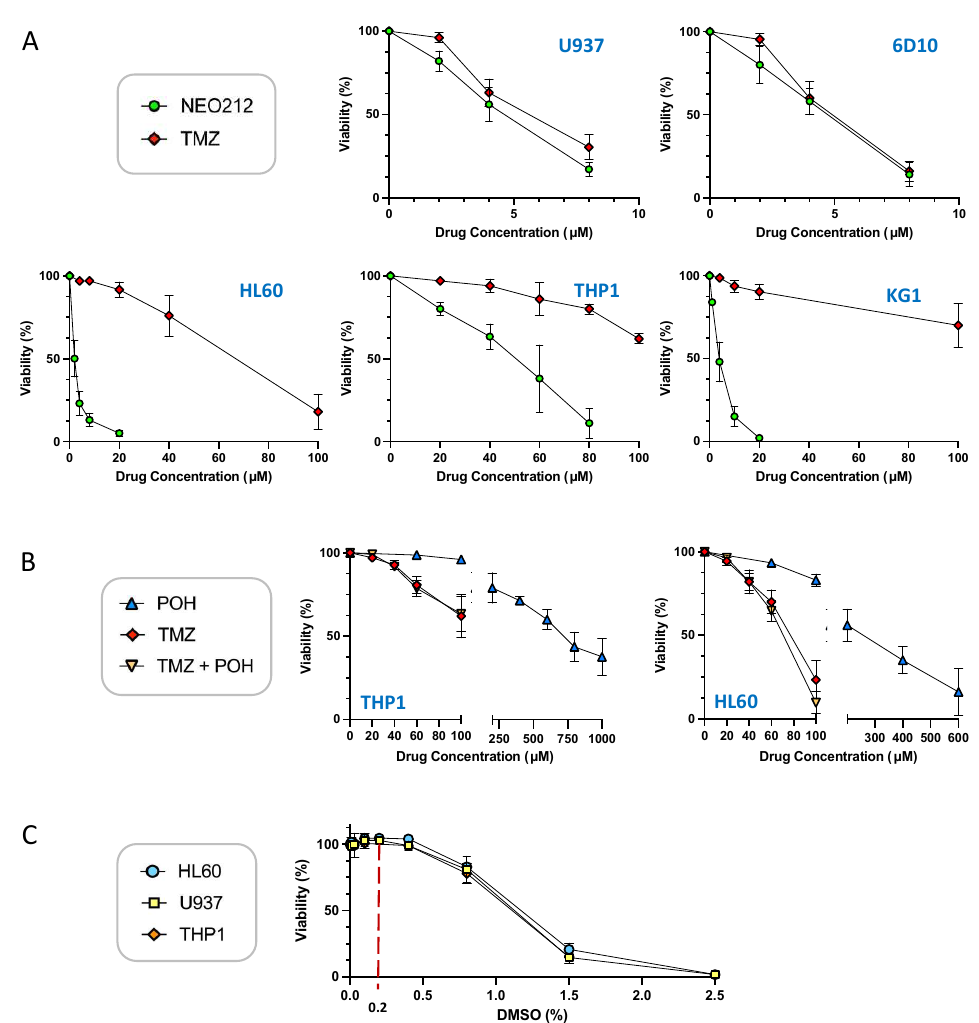
Figure 1. NEO212 is cytotoxic to AML cell lines. U937, 6D10, HL60, KG1, and THP1 cells were exposed to different drug treatment conditions, and cell viability was determined 5 days later by MTT assay. ( A ) Cells were treated with increasing concentrations of NEO212 or TMZ. ( B ) Cells were treated with POH alone, TMZ alone, or POH combined with TMZ. ( C ) Cells were exposed to increasing concentrations of DMSO. All values were normalized to vehicle control at the same time point.